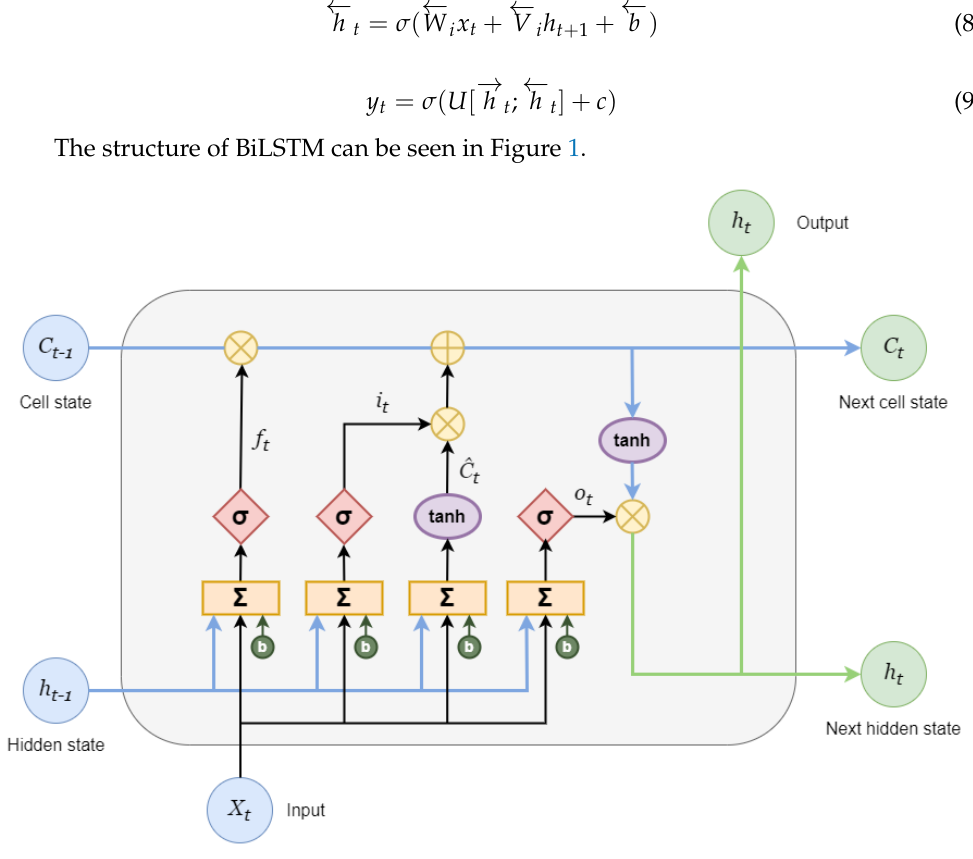
Figure 1. BiLSTM